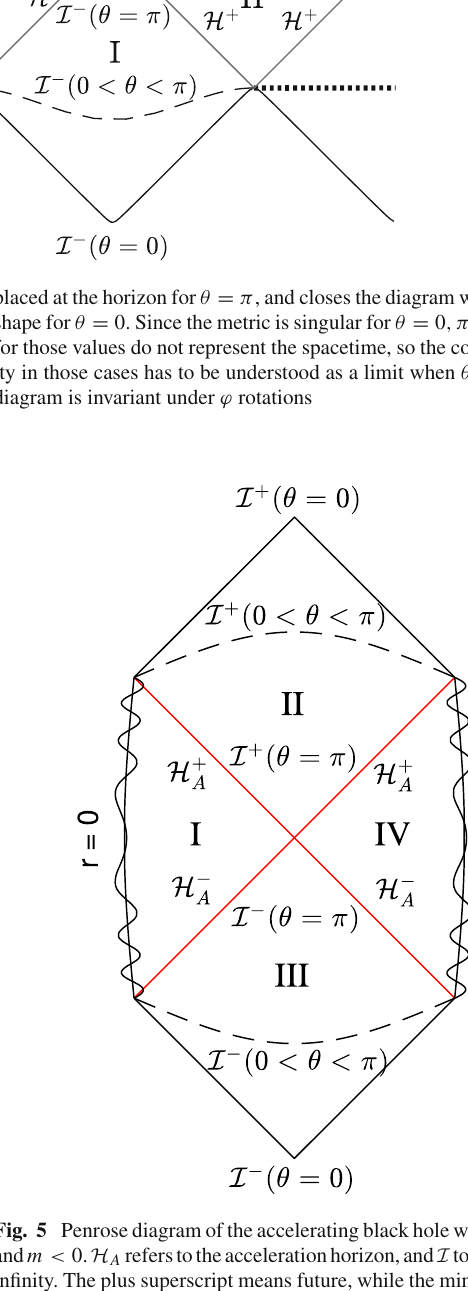
Fig. 5 Penrose diagram of the accelerating black hole with | 2 mA | < 1 and m < 0. H A referstotheaccelerationhorizon,and I totheconformal infinity. The plus superscript means future, while the minus superscript means past. As in previous figures, we show a superposition of different θ = constantdiagrams,whoseconformalinfinitydependsonthechosen value of θ . The diagram is invariant under ϕ rotation